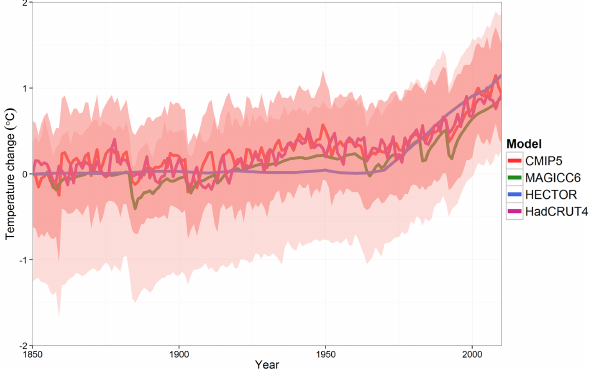
Figure 4. Historical global temperature anomaly relative to 1850 for Hector (blue); MAGICC6 (green); CMIP5 median, standard de- viation and model range (pink, n = 8); and historical observations from HadCRUT4 (purple). Hector is running without the effects of volcanic forcing, leading to a smoother representation of tempera- ture with